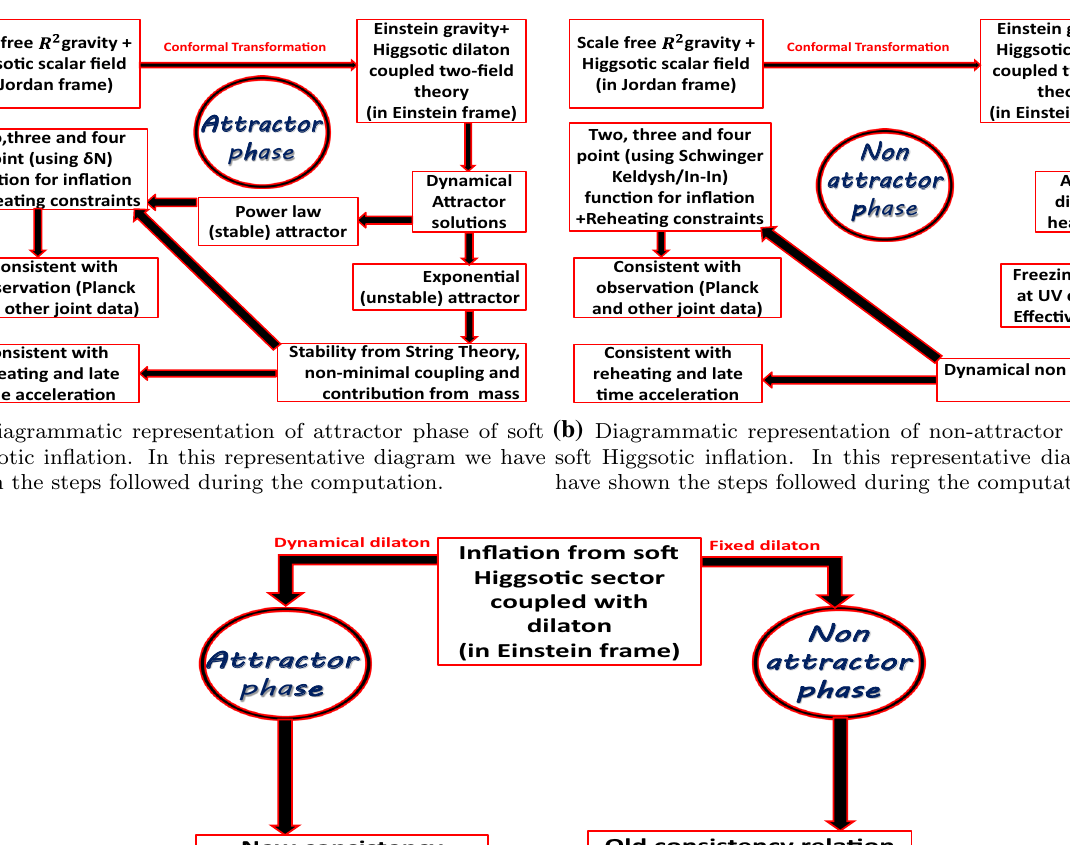
Diagrammatic representation of attractor and non-attractor dynamical